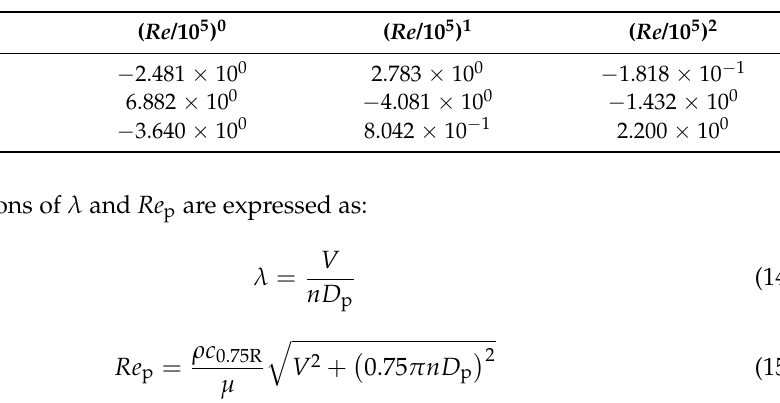
Table 6. Values of coefficient C ij